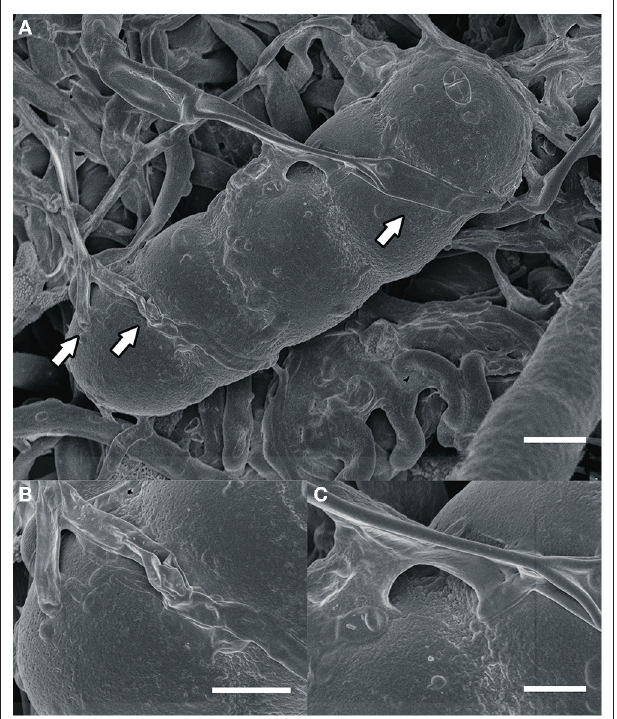
FIGURE 2 | (A) An ascospore of Meliola sp. and hyphae of the hyperparasitic fungus Dimerosporiella cephalosporii (white arrows), as seen by scanning electron microscopy. Bar, 9 µ m (B,C) close-ups of details indicated by arrows in (A) . Bars, (B) 3 µ m, (C) 2 µ